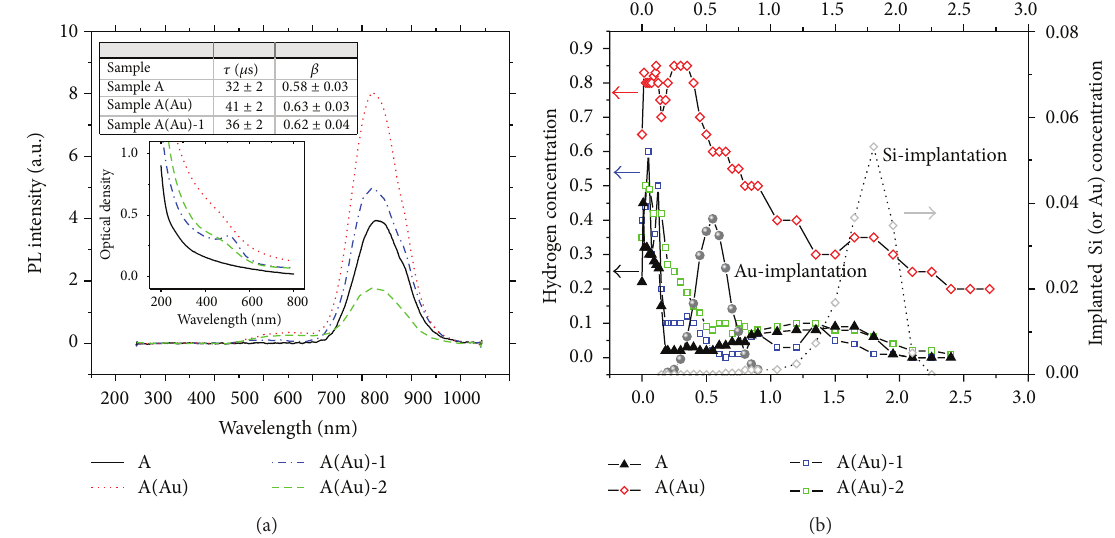
Figure 5: (a) PL emission from samples A, A (Au), and A (Au)-1. Inset graph shows the absorption for each sample. PL lifetime parameters are shown in the inset table. (b) Hydrogen depth profile of the samples A, A (Au), and A (Au)-1. Au depth profile (filled gray circle) by RBS and Si depth profile (open gray rhomb) by SRIM simulation are shown for